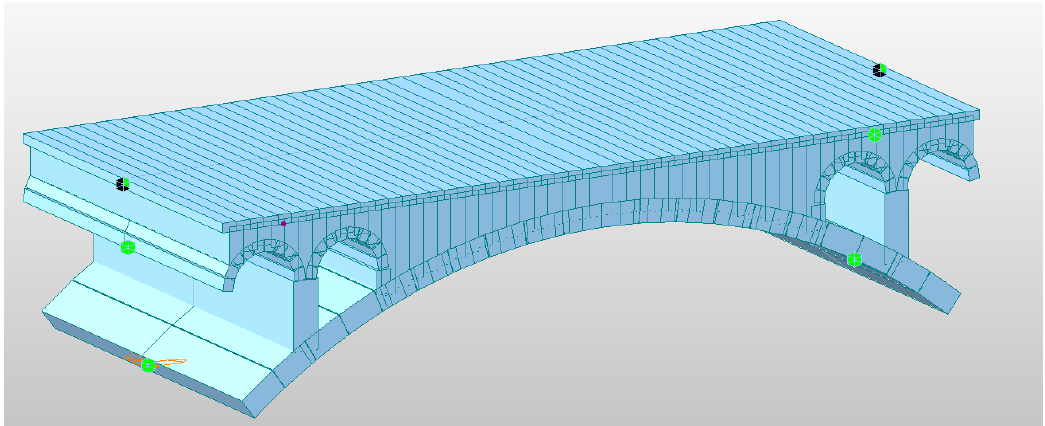
Figure 9. The finite element model of a plate arch bridge.